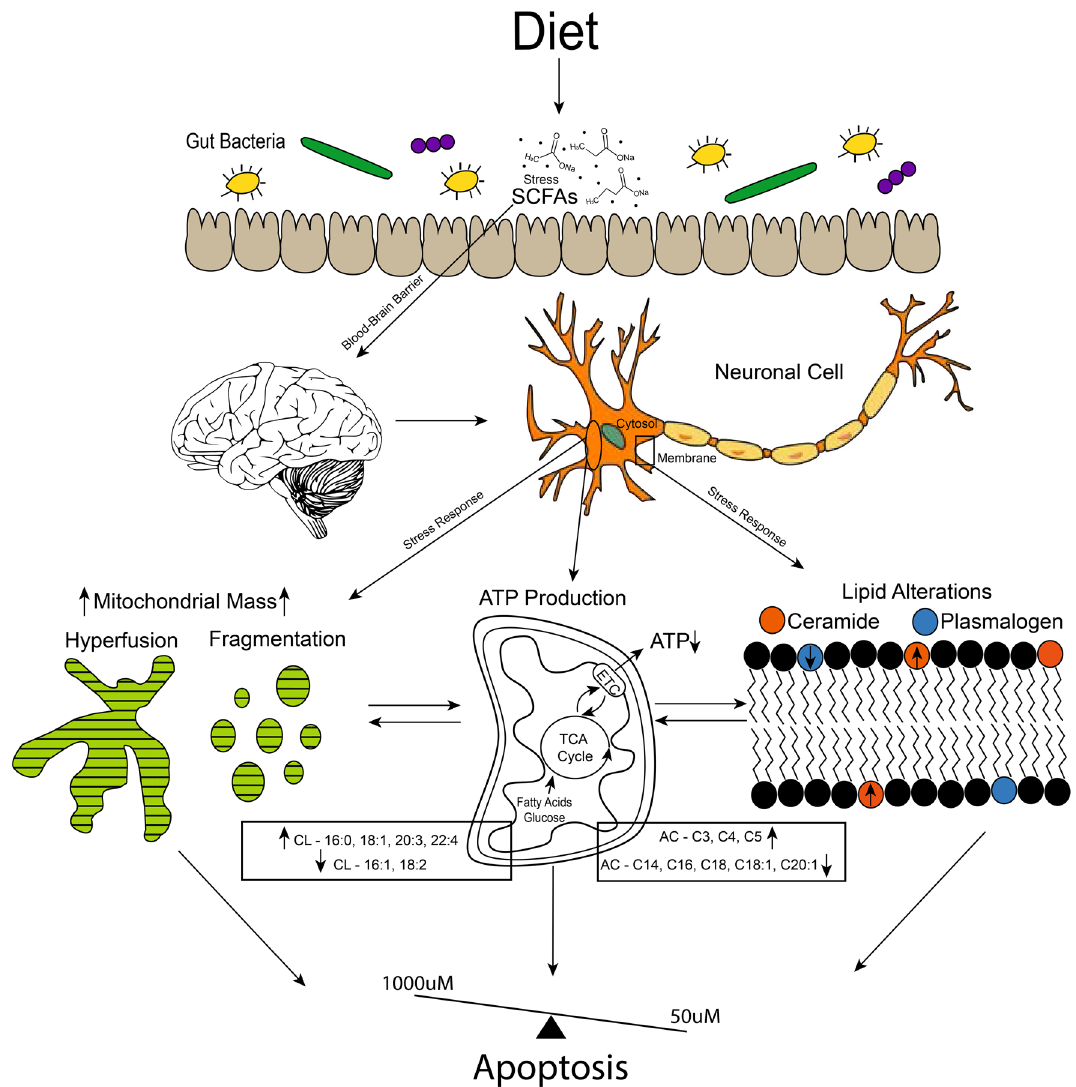
Figure 7. Proposed mechanism for neuronal cell response to levels (50–1000 μM) of SCFAs observed in systemic circulation. SCFAs are received via infermentable carbohydrates in the diet, which are fermented by the gut microbiota population. SCFAs are able to cross the blood–brain barrier (BBB), which at elevated levels caused stress responses in brain neuronal cells. This stress response is shown in our study via alterations in lipids that make up the cell membrane bilayer, such as the increase observed in ceramide vs plasmalogen species. Mitochondrial lipid membrane is also altered, as observed by cardiolipin (CL) and acylcarnitine (AC) profiles. Mitochondria also display increased mass, hyperfusion (1000 μM), fragmentation (50 μM), and decreased ATP production. All of which are linked to apoptotic cell response, which we observed during cell cycle analysis. Although the 100 μM treatment is not completely normal, it does not show major alterations compared to the 50 μM and 1000 μM treatments. This suggests a possible dose balance response between the between the SCFA induced alterations in brain mitochondrial lipid metabolism, morphology, and the neuronal cells apoptotic response (Fig. 7). Furthermore, mitochondrial morphological analysis revealed high levels of mitochondrial fragmentation (50 µM) and hyperfusion (1000 µM) after treatment with SCFAs (Fig. 4C,D). Fragmentation is characterized by many small and round mitochondria, whereas hyperfusion is characterized by connected and elongated mitochondria 44 . Fragmentation and hyperfusion play a role in cellular quality control, and cells continually alter the rate at which these occur based on energy demands 23,25,45 . However, mitochondrial fragmentation is a hall- mark of apoptosis and may result from nutrient overload (i.e. SCFA). Furthermore, mitochondrial fragmentation can occur directly from apoptotic signals, or cause apoptotic signals 24,25,45,46 . While fragmentation is a normal and beneficial process in some functions of the body such as the increased energy demand of exercise 47 , it has been observed in mitochondrial dysfunction related to overall brain health and aging, such as in PD and AD 46,48,49 . We hypothesize that hyperfusion within the 1000 µM treatment is likely a stress response to damaged molecules or